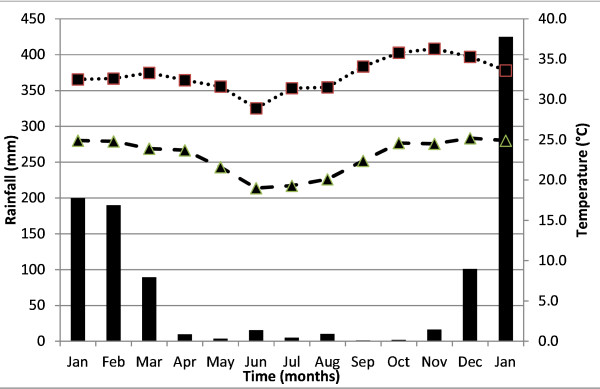
Monthly abundance ofAn. arabiensis, An. gambiae s.s.andAn. funestusfrom Chipula and Kela in the lower Shire valley, as measured by pyrethroid knockdown catch (Jan 2002 - Jan 2003).